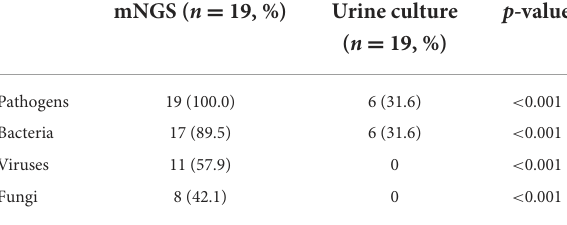
TABLE 4 The positive rate between mNGS and urine culture. TABLE 5 Adjustment of antibiotic treatment according to mNGS